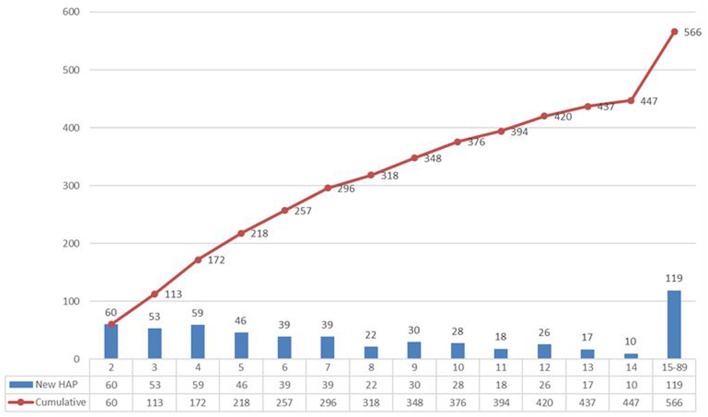
Daily and cumulative of occurrence of HAP in patients with HAP. The median of duration from admission to diagnosis of HAP was 7 days (IQR, 4–13) and the mode was 2 days.